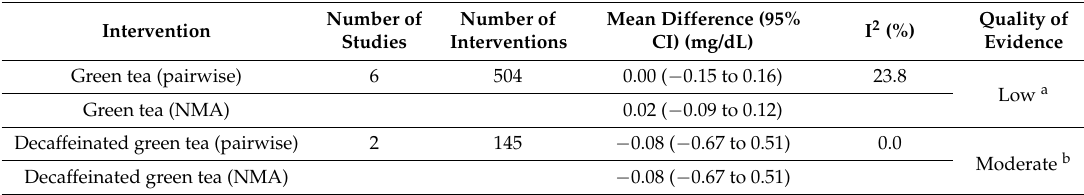
Table 4. Intervention effect on HbA1c vs. placebo/water.